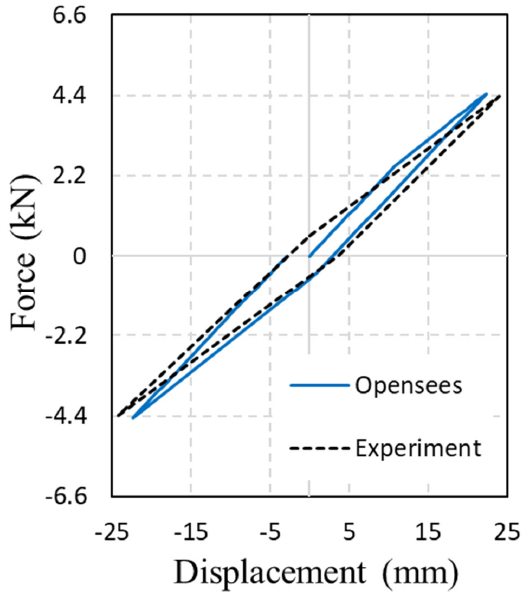
Figure 14. Numerical and experimental results (second cycle).